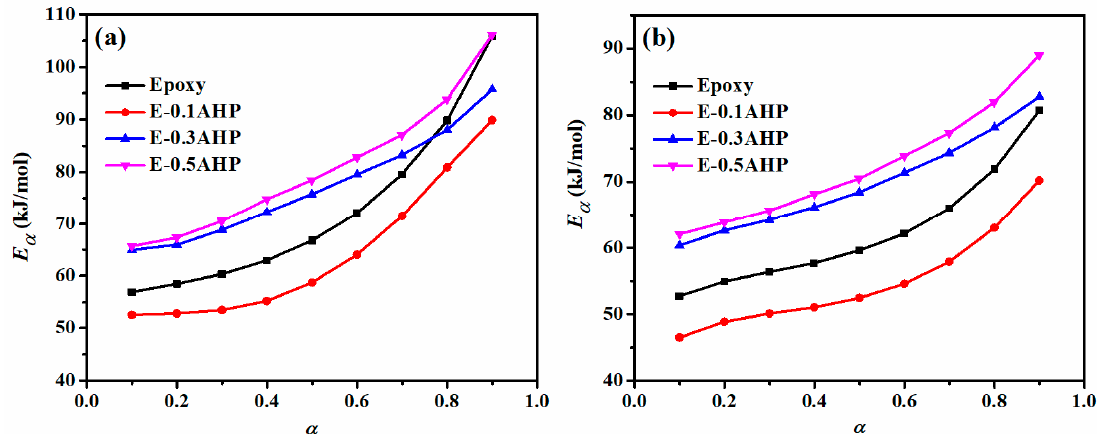
Figure 6. Evolution of activation energy as a function of the extent of cure reaction for epoxy and AHP/epoxy nanocomposites estimated by ( a ) differential Friedman and ( b ) integral Kissinger methods.